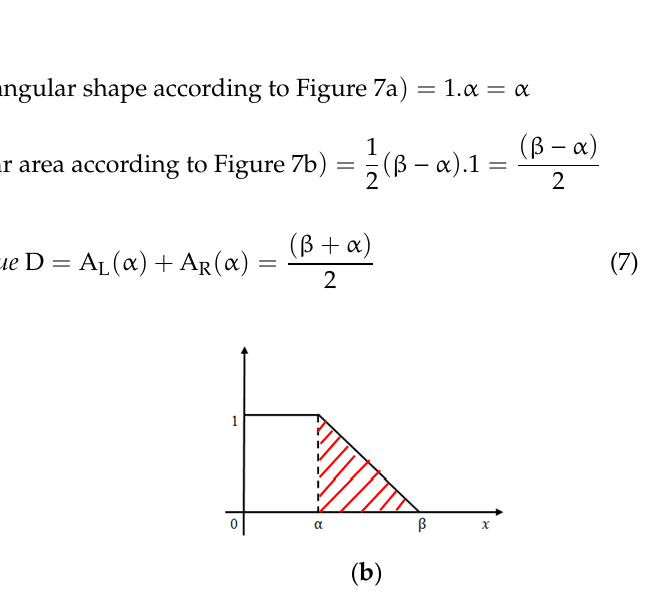
Figure 7. ( a ) Left zone. ( b ) Right zone .